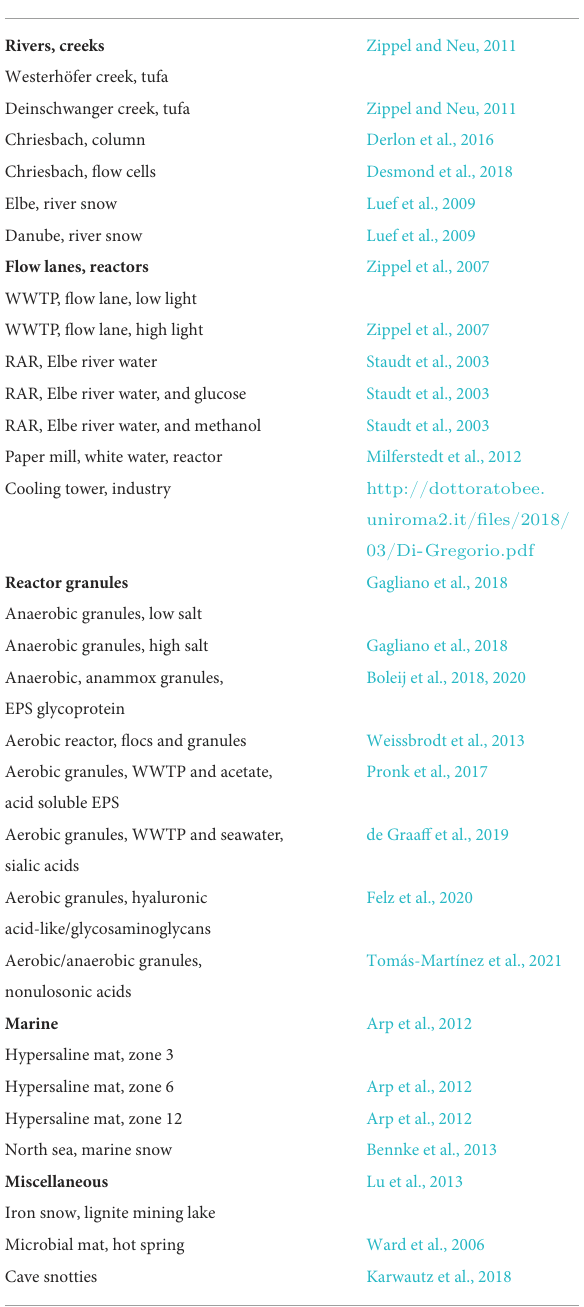
TABLE 1 List of habitats and origin of biofilm samples together with the reference of originally published data.